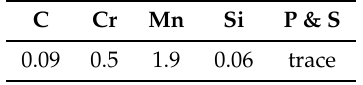
Table 2. Chemical composition (wt %) of the DP600 steel (TATA Steel, Ijmuiden, The Netherlands) after which the representative volume elements (RVEs) are modeled.